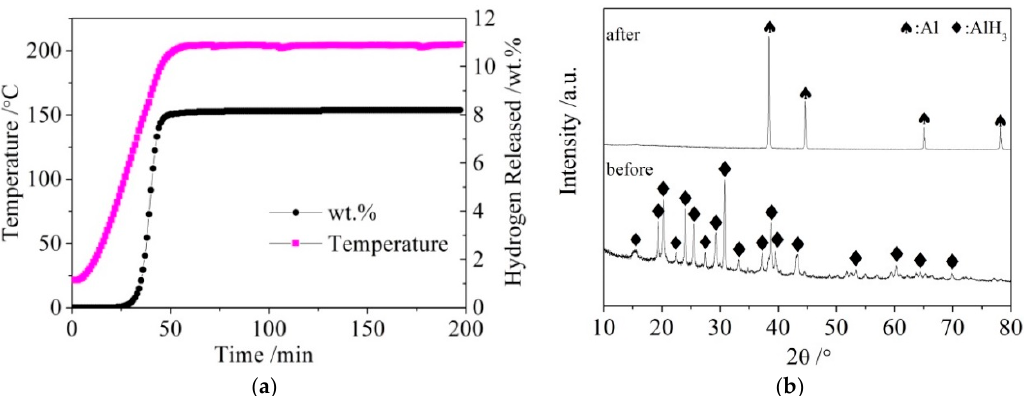
Figure 1. The dehydrogenation curves ( a ) of AlH 3 and X-ray diffraction (XRD) patterns ( b ) of AlH 3 before and after dehydrogenation.